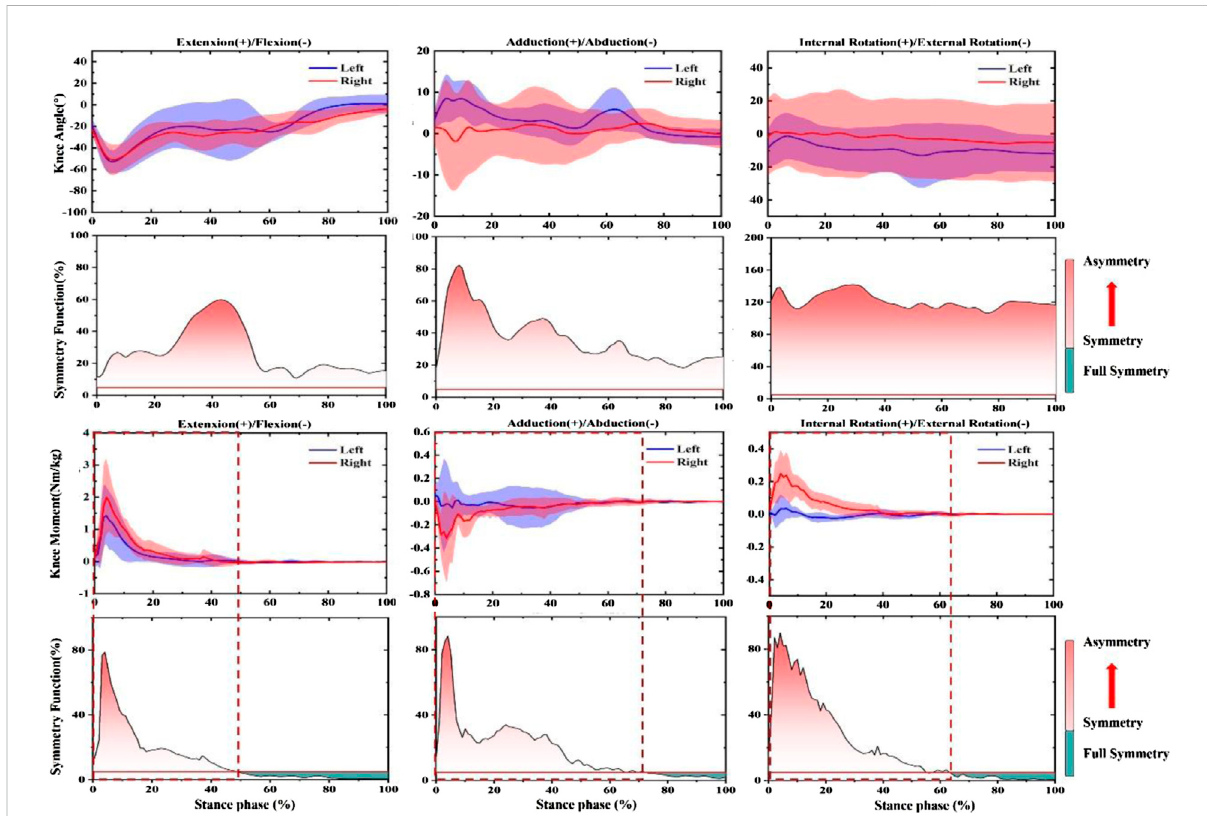
FIGURE 5 IllustrationofSFdegreeinbilateralkneejointangleandmomentduringlandingphaseafterprolonged-runningprotocolfortheCMJtest.Note: The red fi ll represents the degree of asymmetry, and the darker the color, the more asymmetry. The green fi ll represents full